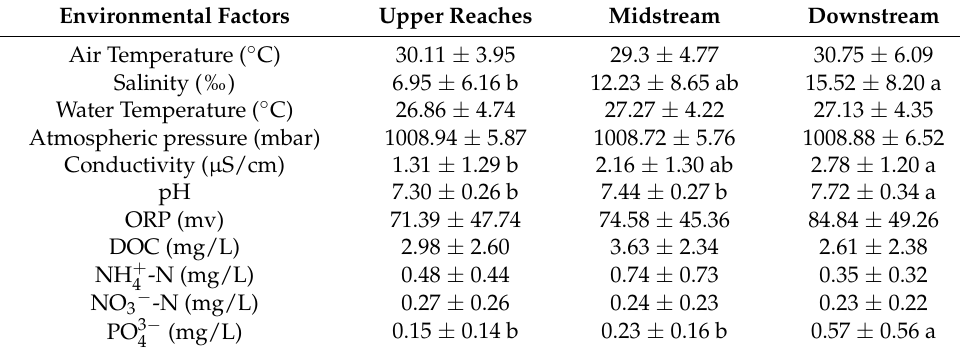
(Table 1). In addition, salinity, water temperature, conductivity, ORP, and air temperature also varied seasonally (Figure 3a–g). Table 1. Environmental factors and properties of water in Yanfeng river.